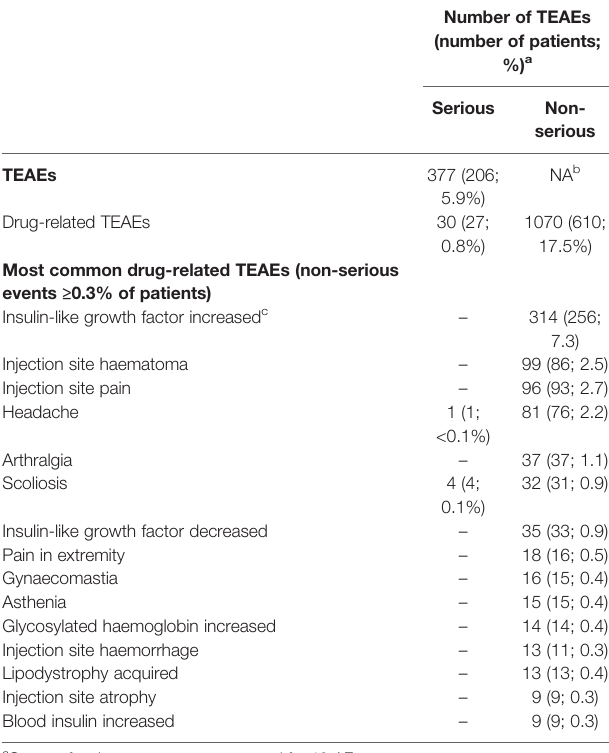
TABLE 3 | Overview of frequently reported TEAEs – Safety population